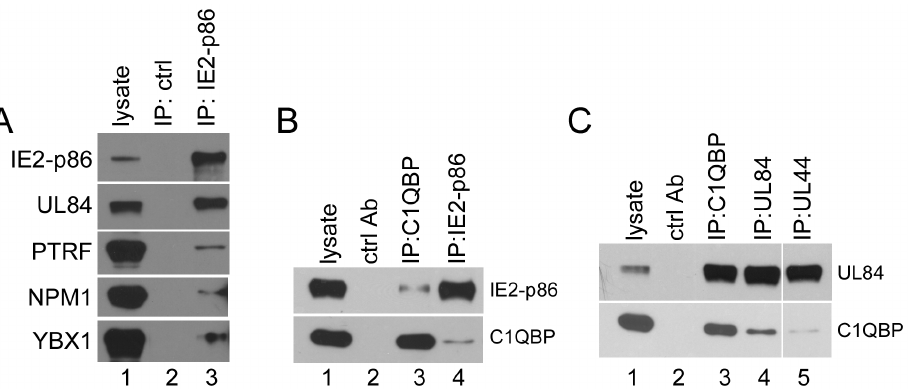
Figure 5. Association of cellular proteins with viral proteins IE2-p86, UL84 and UL44 in co-immunoprecipitation. HFF cells were infected with wt Towne at an MOI of 2 PFU/cell, harvested at 48 h p.i. for immunoprecipitation with specific antibodies against C1QBP (A, B and C), IE2-p86 (A and B), UL84 (C), UL44 (C), or isotype antibody control (ctrlAb). The precipitates were fractionated by 10% SDS-PAGE. Proteins were detected by Western blot with indicated specific antibodies (PTRF, NPM1, YXB1, and C1QBP) as described in the Materials and Methods. Since the heavy chain of the antibody used in co-immunoprecipitation migrates to the same location as UL44, and overshadows the signal of UL44, the protein UL84 was examined in anti-UL44 precipitates (C).